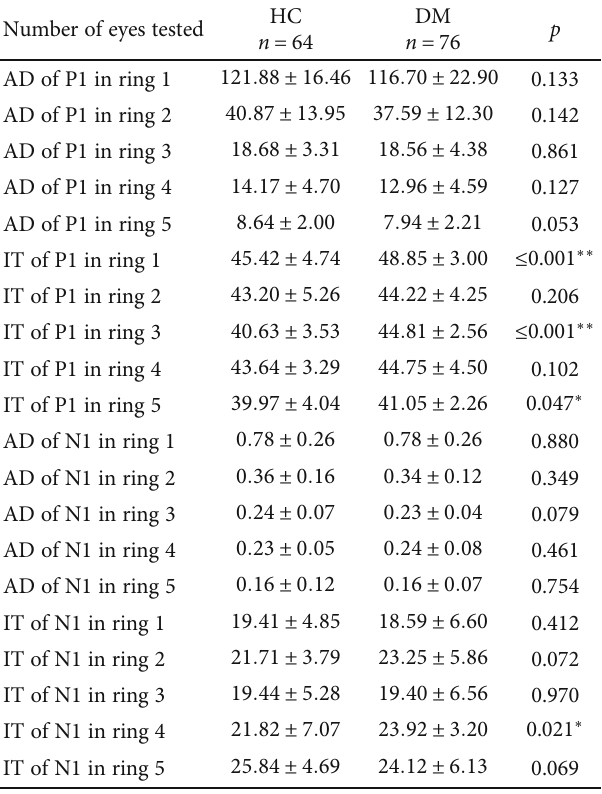
Table 2: Retinal function analysis of DM patients and healthy subjects using mf-ERG examinations in healthy controls and DM patients.